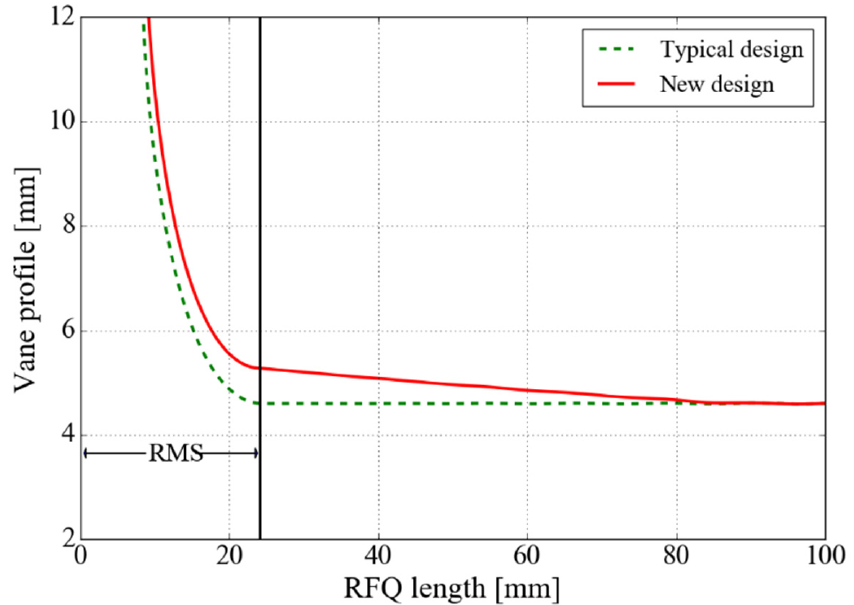
Figure 1. Vane profile at the initial cells under two design methods.